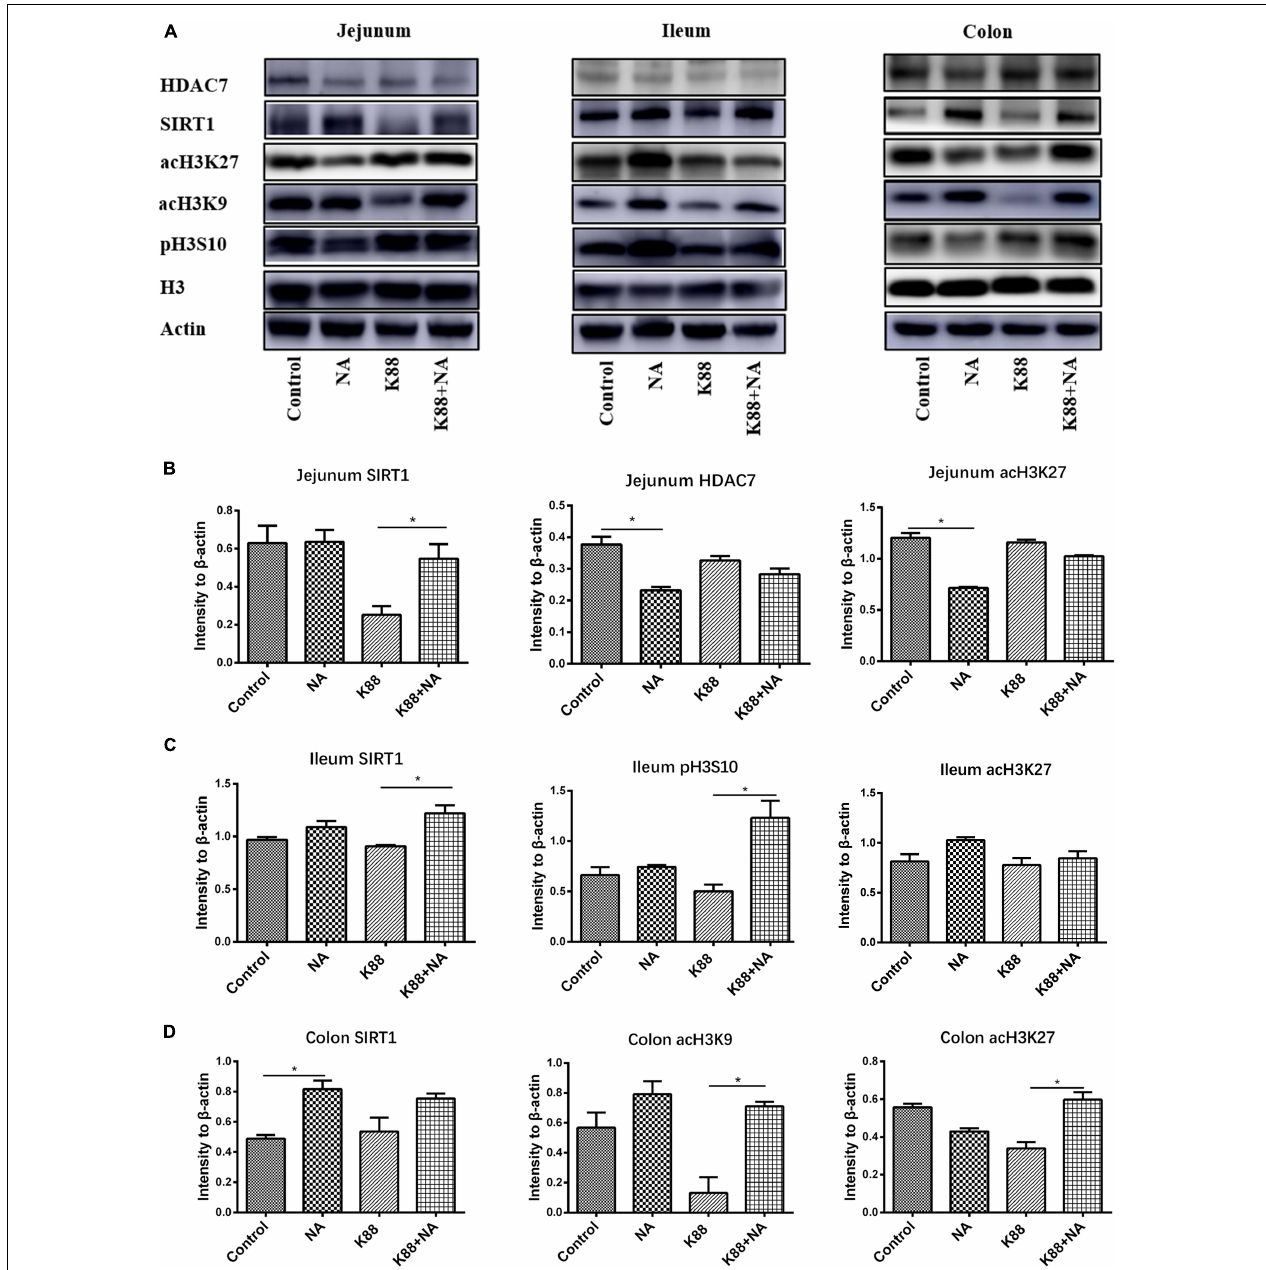
FIGURE 8 | Effects of nicotinic acid on the histone deacetylase modification in intestinal mucosa caused by E. coli infection of weaned piglets. The expression of histone deacetylase SIRT1, HDAC7, and modification sites such as acH3K9, acH3K27, and pH3S10 in the promoter region in the jejunum, ileum, and colon mucosa were determined by Western blot (A) . The intensity of the bands was detected using ImageJ, densitometric values were normalized to those of β -actin in the jejunum (B) , ileum (C) , and colon (D) . * P <